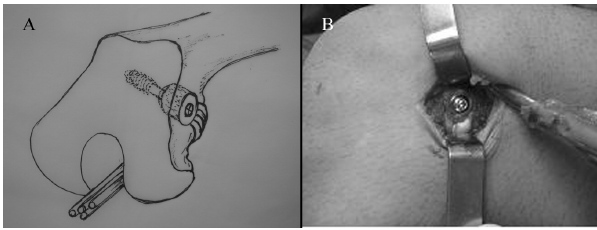
Figure 3 - (A) Drawing of the bone washer pressing the tendons against the bottom of the larger hole when connected to the screw. (B) Picture of final fixation.